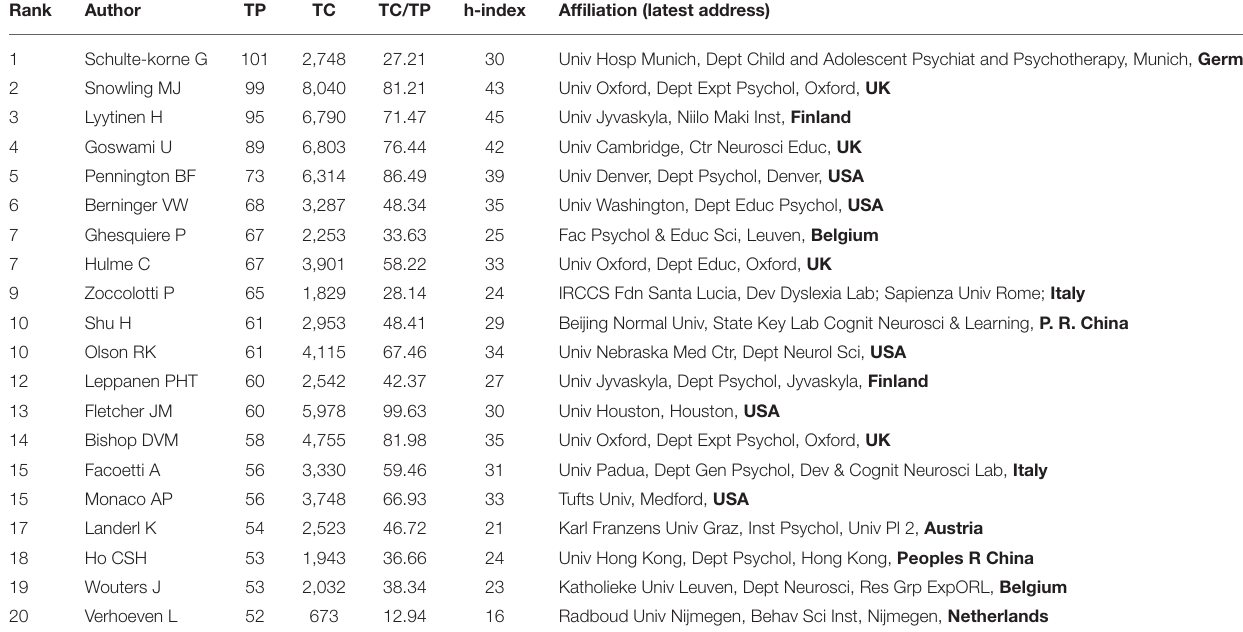
TABLE 2 | The top 20 most productive authors of publication, and h-indices during